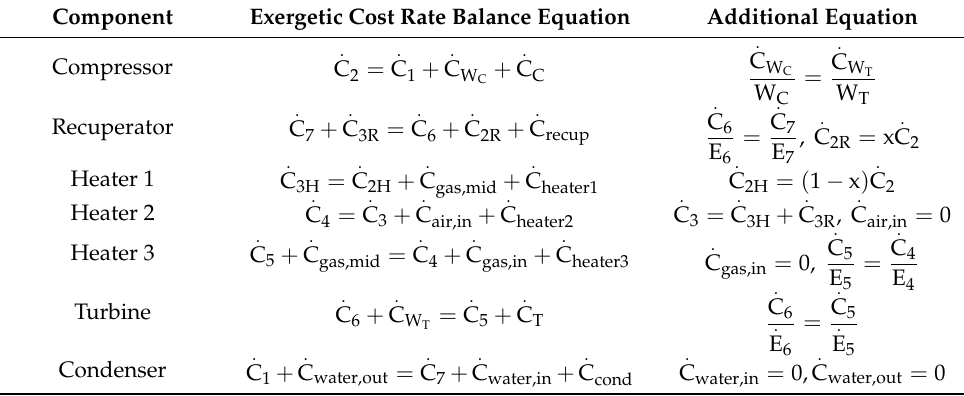
Table 5. Exergetic cost rate balance equations of an optimum split cycle [37].